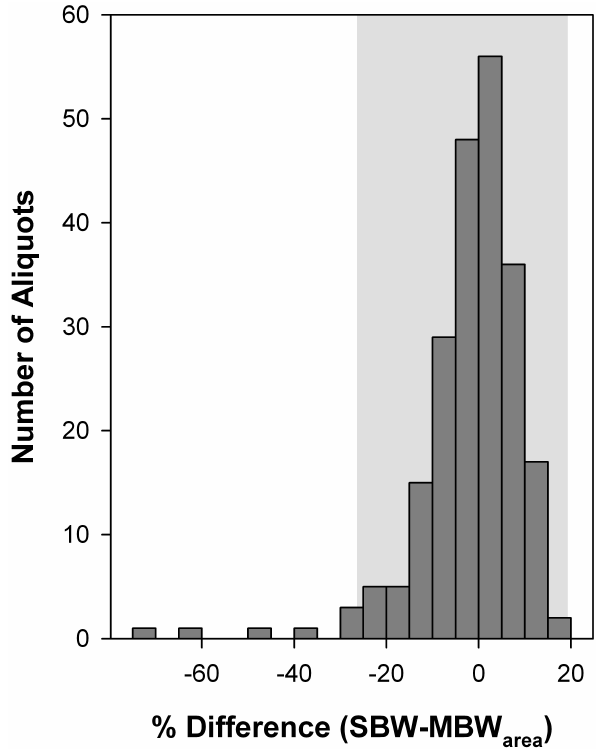
Fig. 3. The difference between “sieve-based weight” (SBW) and area-normalised weight (MBW area ). The grey shaded area repre- sents the theoretical extreme differences, assuming that the speci- mens are effectively sieved and spherical (refer to